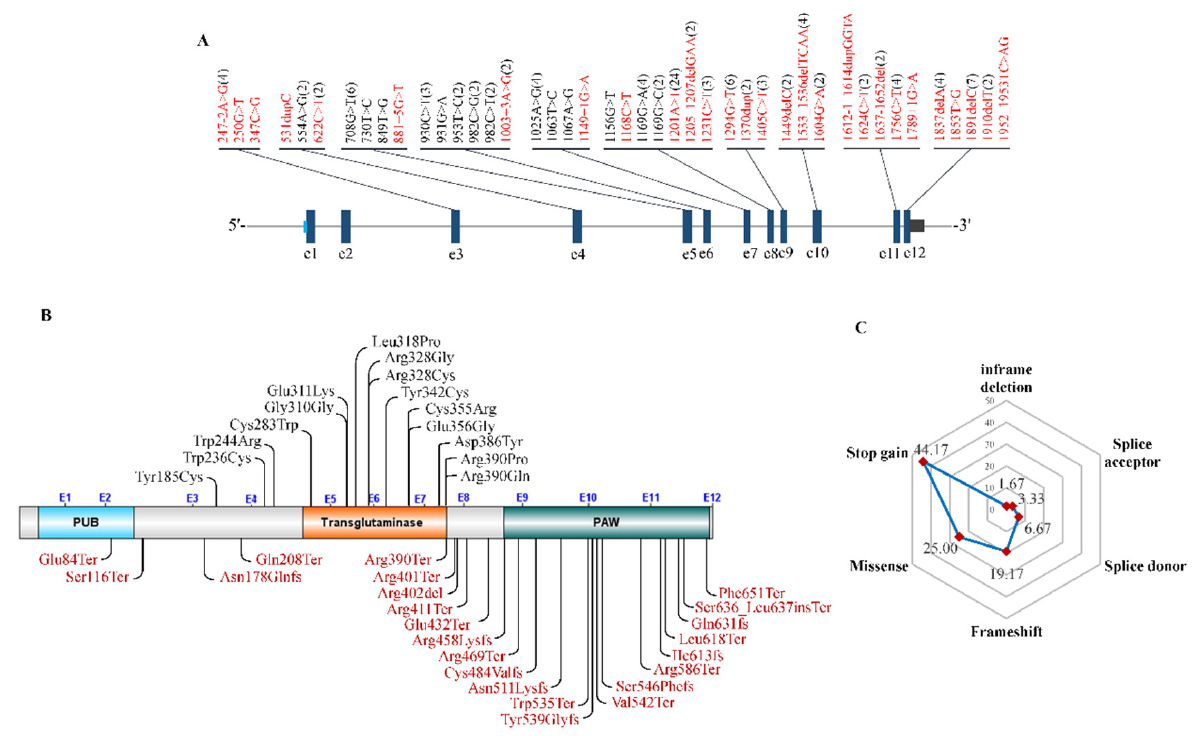
Figure 9. Characterization of mutations of NGLY1. ( A ) mRNA locations; ( B ) Amino acid locations; ( C ) Different types of mutations.